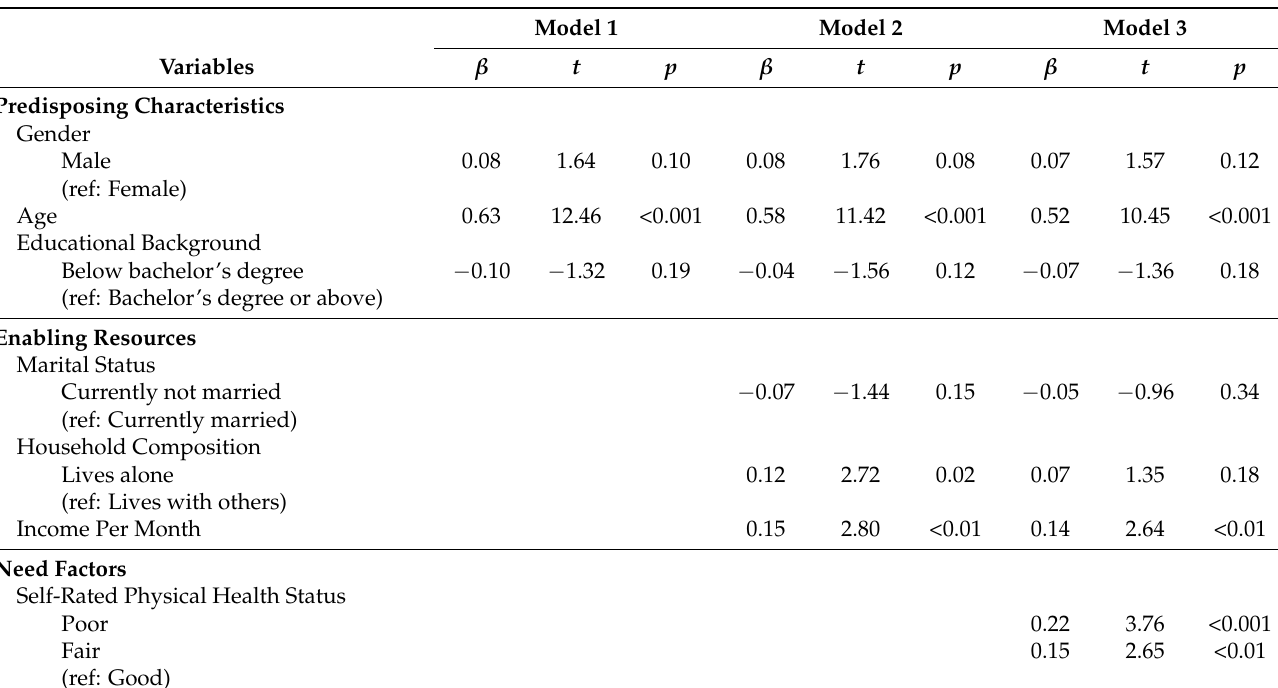
Table 4. Hierarchical Regression Analysis of Factors Influencing the Intended Use of Basic Medi- cal